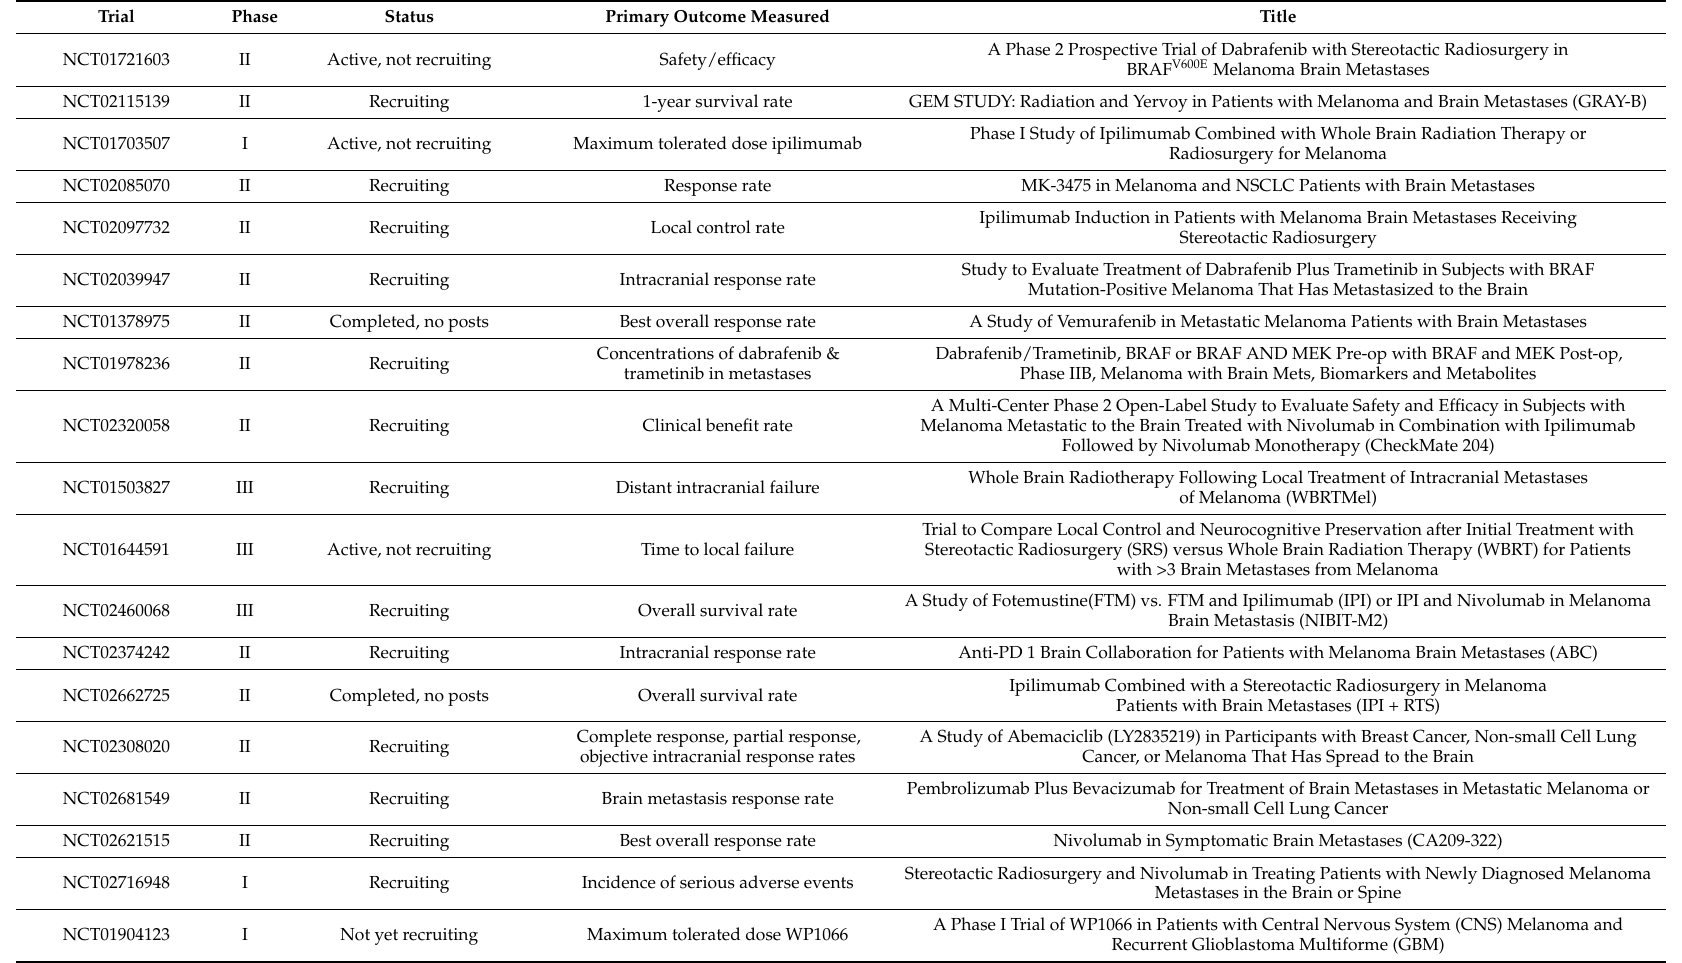
Table 1. Summary of clinical trials in progress for patients with metastatic melanoma 1